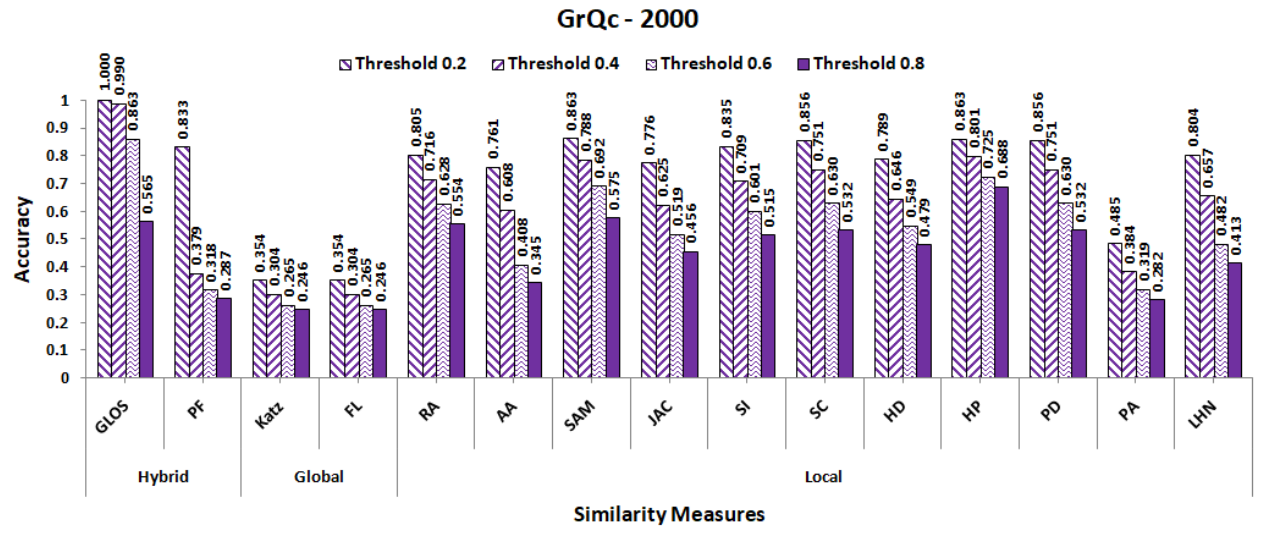
Figure 15. Comparisons of similarity measures on GrQc-1500 edge list from GrQc